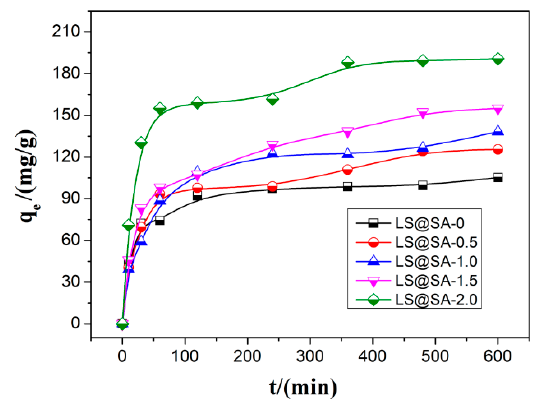
Figure 6. Effect of contact time on the adsorption capacity of adsorbents for MB. Adsorption experiments, C 0 : 500 mg/L; pH: 6.50.